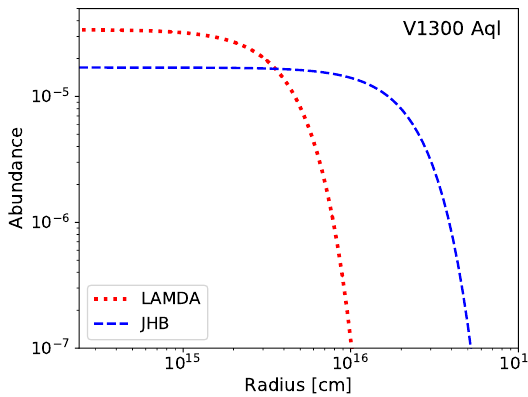
Figure 1. An example of different abundance profiles for H 2 S derived from the same observations based on modelling with different collisional rates with Gaussian abundance distributions. Original modelling and data presented are from